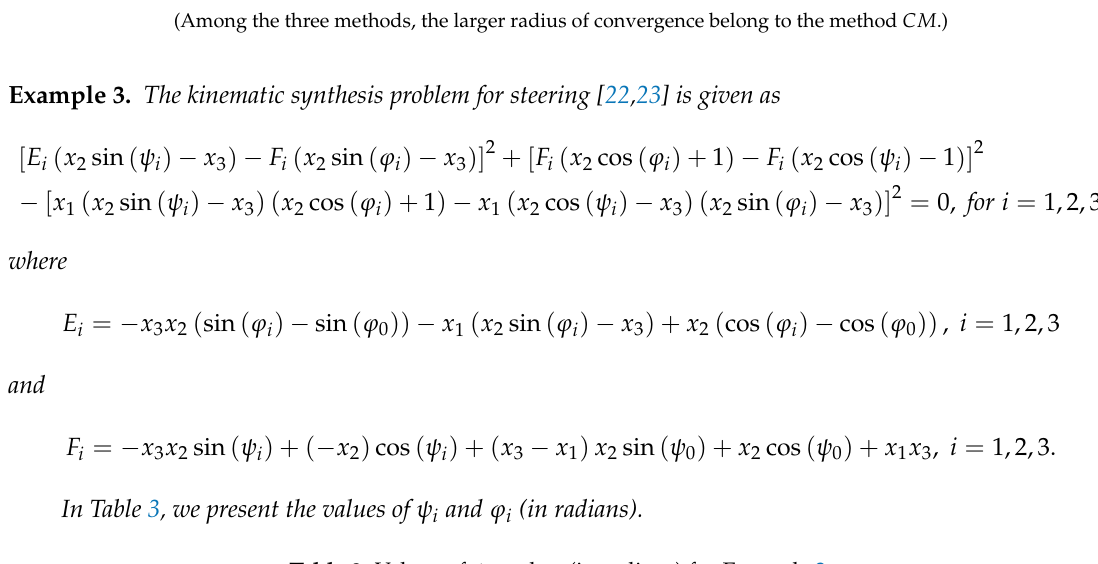
Table 3. Values of ψ i and ϕ i (in radians) for Example 3.